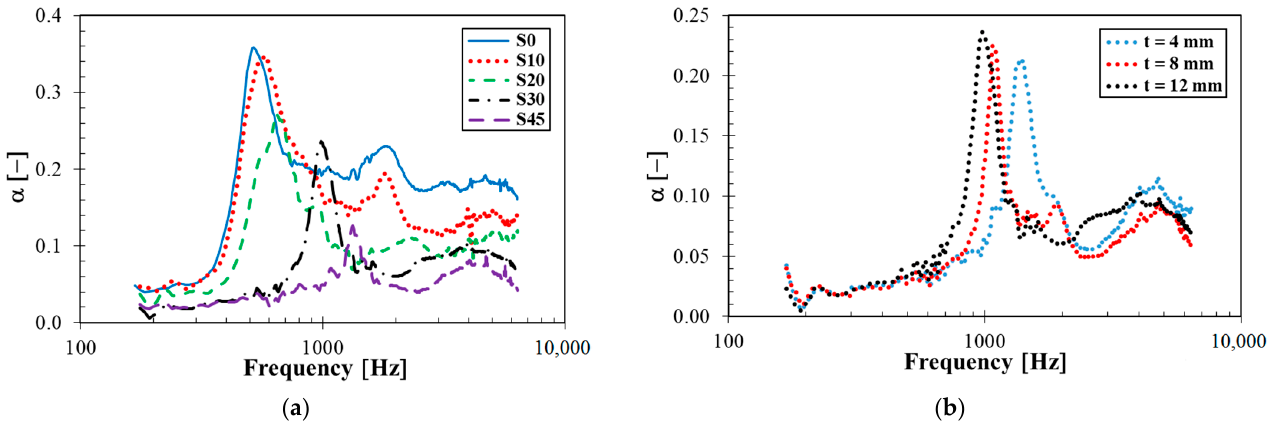
Figure 9. Frequency dependencies of the sound absorption coefficient: ( a ) Rubber samples measuring t = 12 mm in thickness at different concentrations of silica filler; ( b ) rubber samples of various thicknesses with 30 phr of silica filler. Table 6. Values of noise reduction coefficient (NRC) of the studied rubber composites.